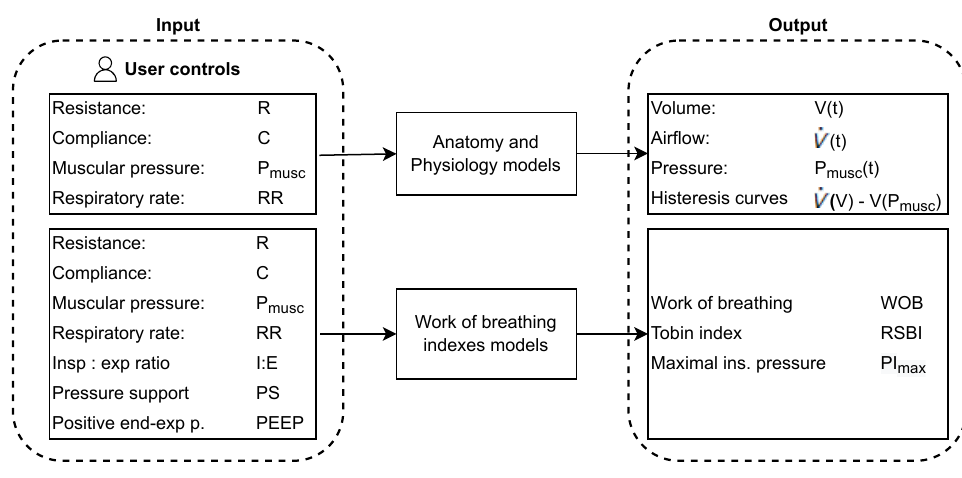
Figure 1. Simplified system of the application’s interactivity, emphasizing the input parameters and the output predicted